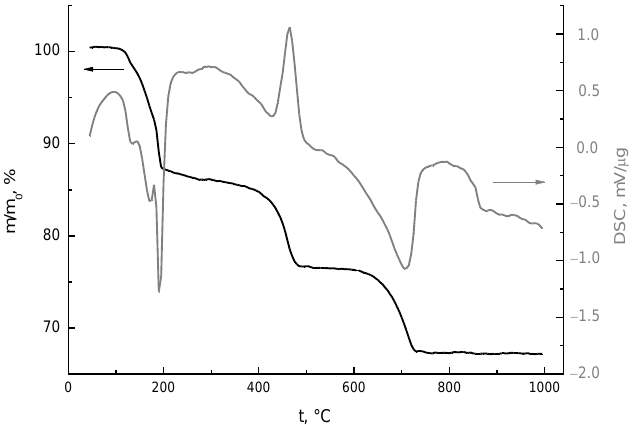
Figure 3. The results of synchronous thermal analysis (TA): thermogravimetry curves (TG, in black) and differential scanning calorimetry (DSC, in gray).